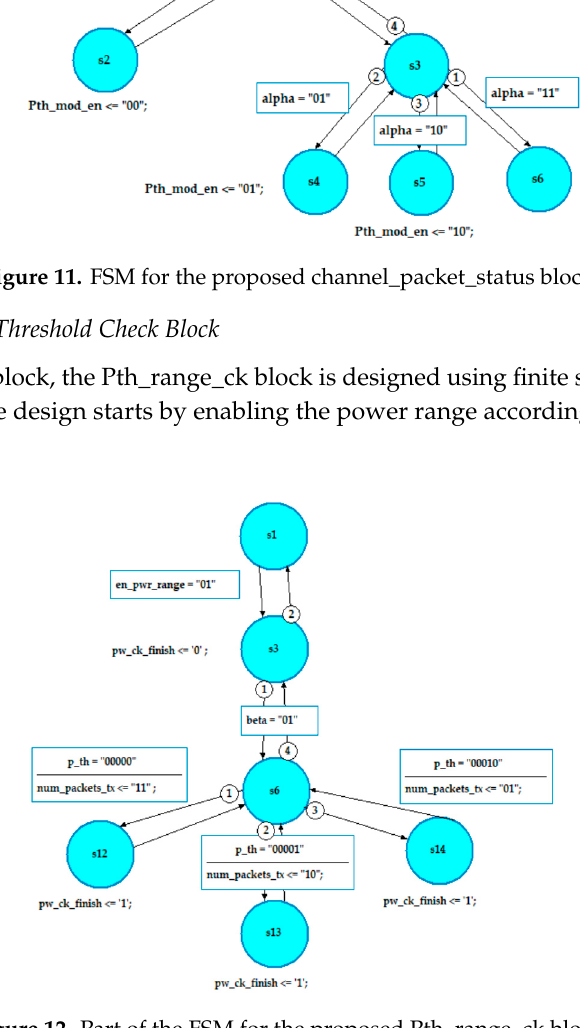
Table 3. Place and Route Results.